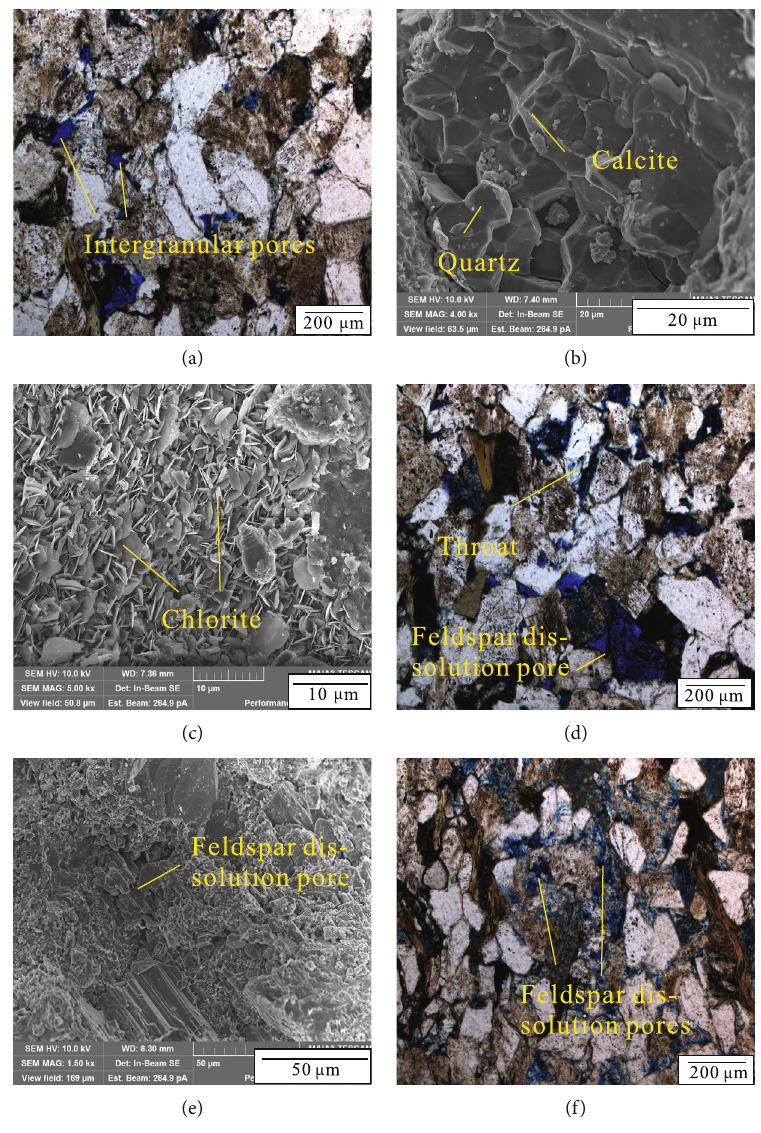
Figure 4: CTS and SEM analyses. (a) Intergranular pores, CTS. (b) Quartz cement and Calcite cement, SEM. (c) Chlorite cement, SEM. (d) Throat, CTS. (e) Feldspar dissolution pores, SEM. (f) Feldspar dissolution pores,